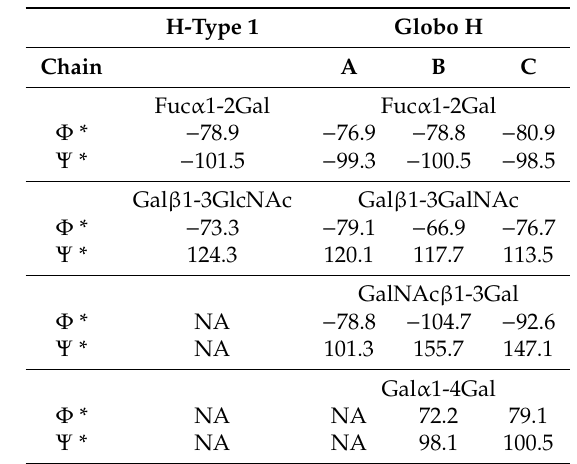
Table 4. Dihedral angle measured for the observed glycosidic linkages of H-type 1 and Globo